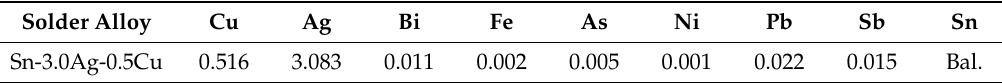
Table 1. Chemical composition of solder alloy (wt. %).